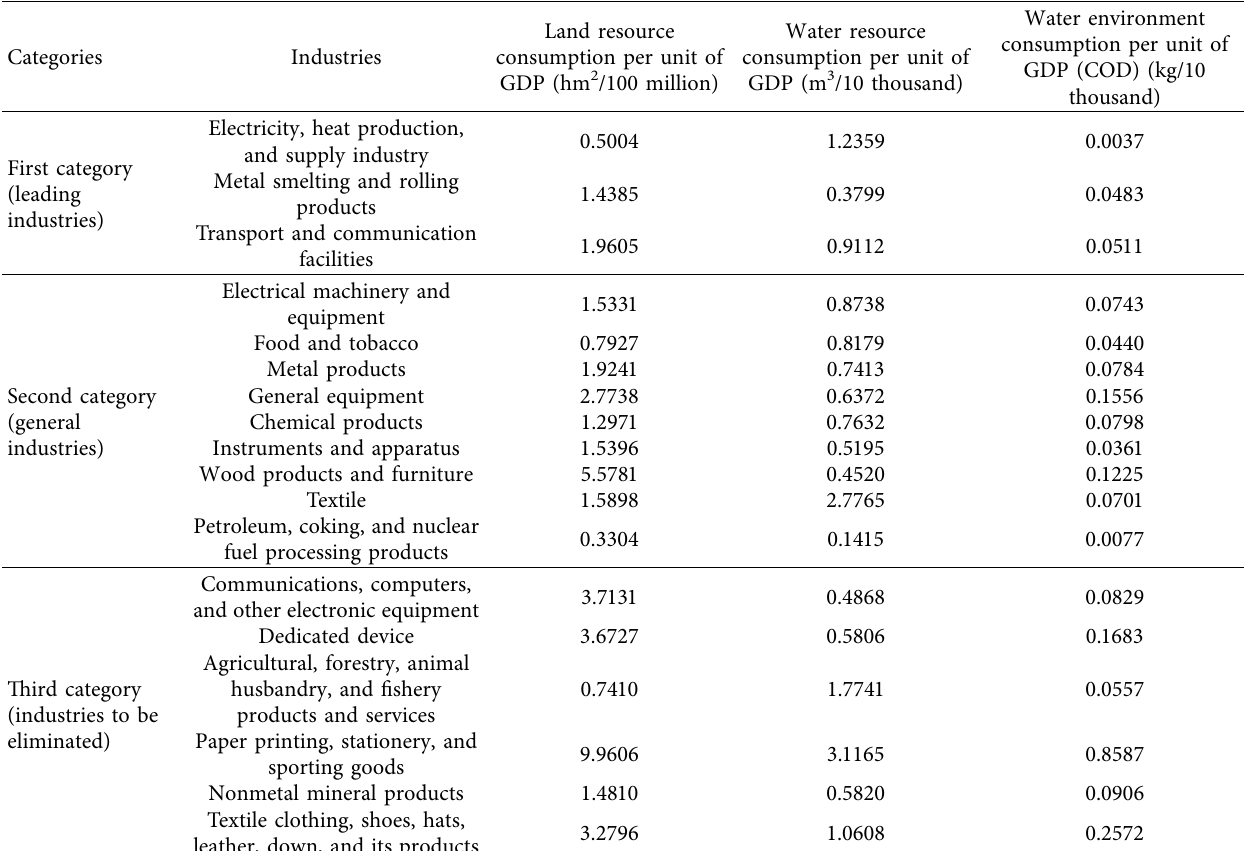
Table 2: Resource and environmental consumption per unit of GDP by industries in Jinjiang City, Jiangsu Province.